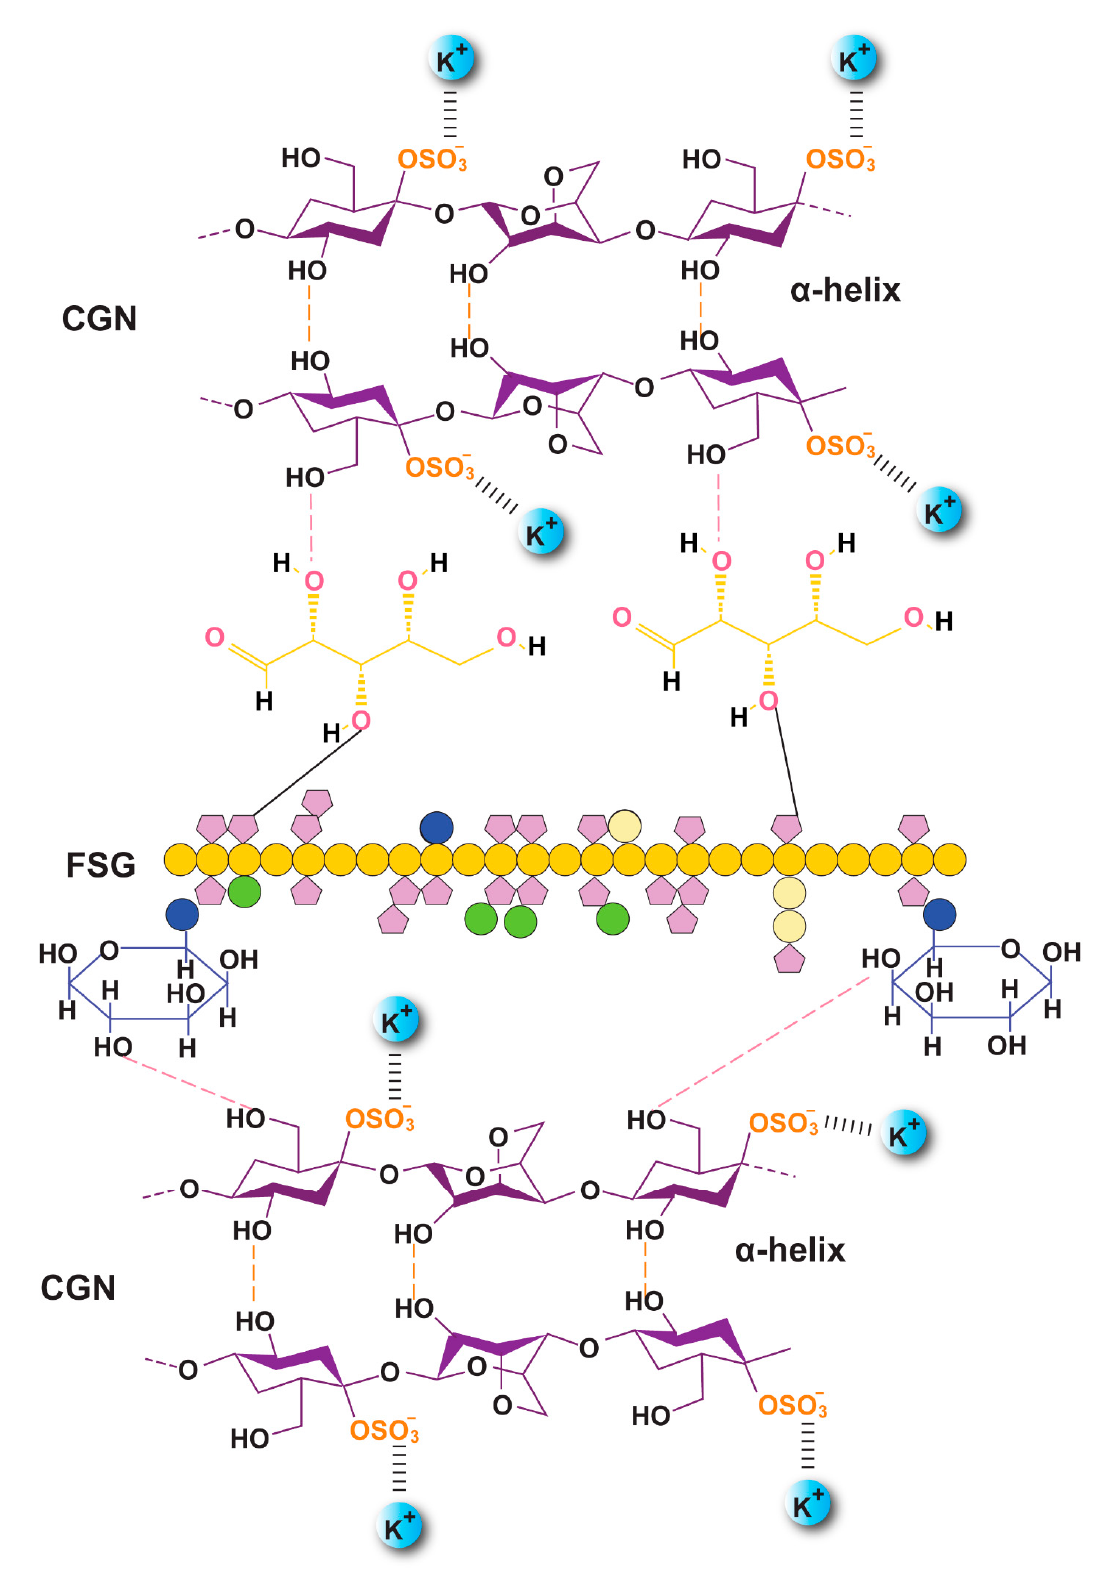
Figure 5. Proposed orientation of the CGN and FSG in the crosslinked biocomposite film along with probable hydrogen bonding (F 1 C 1